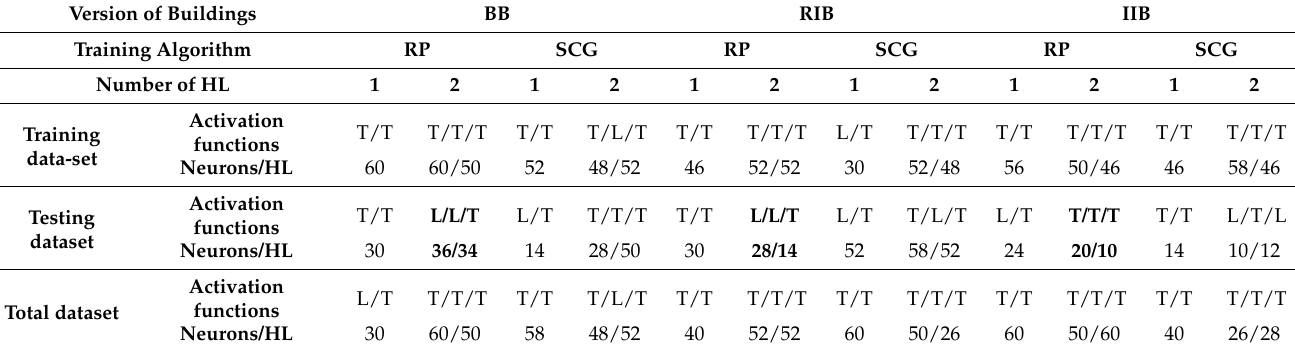
Table 6. The parameters of the optimally configured networks used for the implementation of A1.